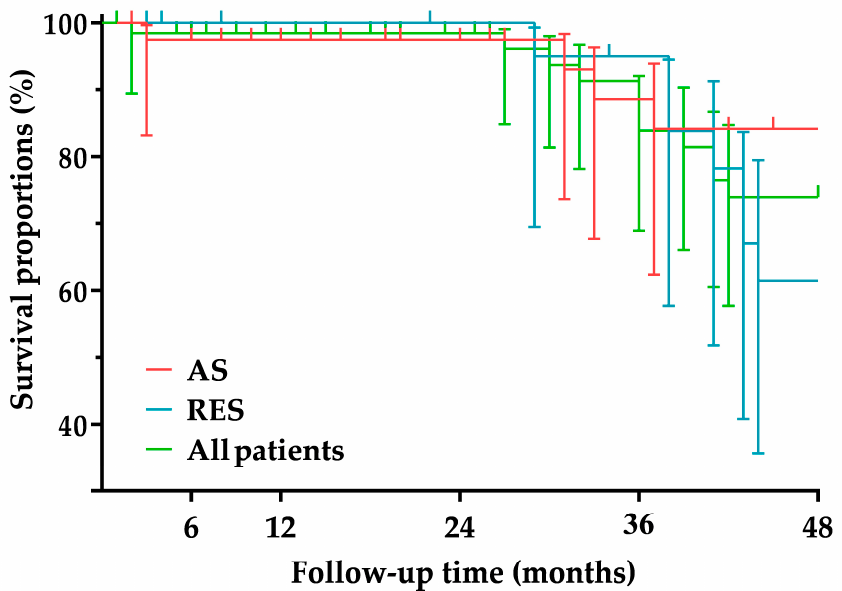
Figure 2. Survival proportions. AS, Atherosclerotic; RES, restenotic. Table 6. Survival